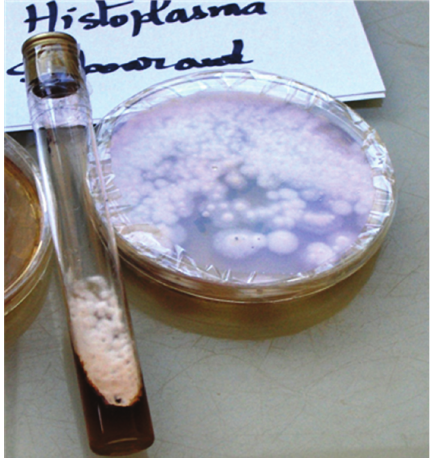
Figure 3: Histoplasma capsulatum colonies in Sabouraud